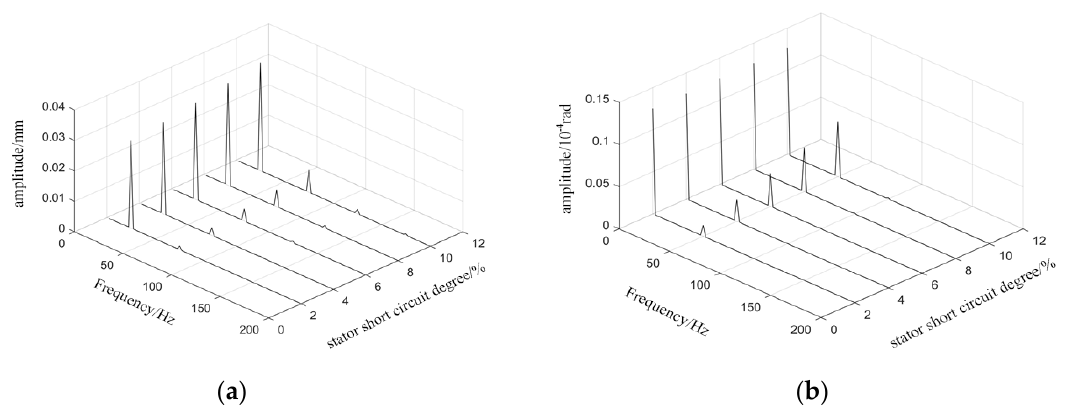
Figure 7. Vibration response frequency waterfall diagram with stator short-circuit fault: ( a ) Radial vibration; ( b ) Torsional vibration.